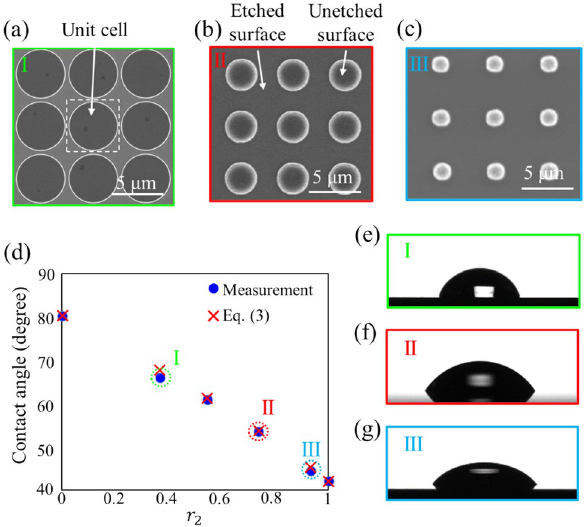
Figure 3. The SEM images of the surface consisting of the homogenous cell array with r 2 = ( a ) 0.37 ( d const = 4.75 µ m ), ( b ) 0.74 ( d const = 3.0 µ m ), and ( c ) 0.93 ( d const = 1.5 µ m ). ( d ) The measured and calculated contact angles as the function of r 2 . The conditions of r 2 = 0 and 1 imply unetched and etched surfaces overall, respectively. The side-view photographs of the water droplet with r 2 = ( e ) 0.37, ( f ) 0.74, and ( g ) 0.93. The contact angle and ratio r 2 in ( d ) were calculated from Eqs. (2b) and (3) with each designed value of d const , respectively.